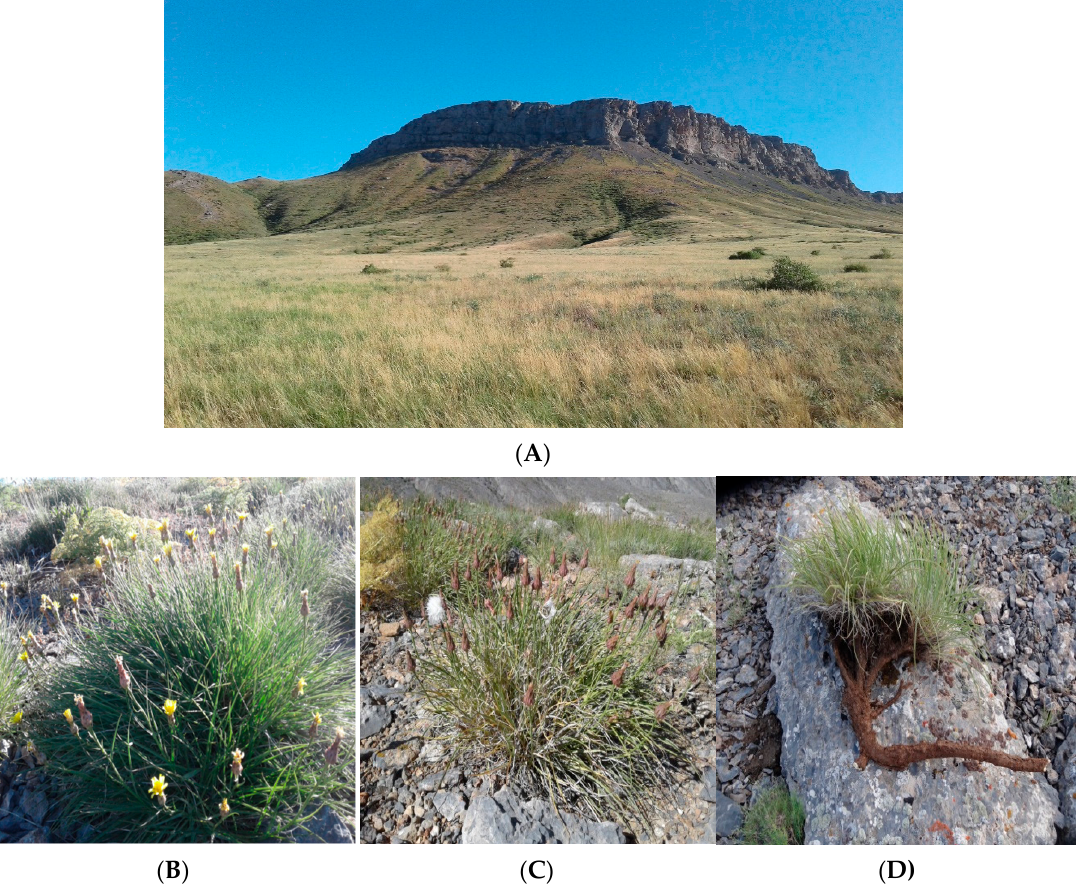
Figure 1. The rare, endangered rubber species Scorzonera tau-saghyz Lipsch. et G.G. Bosse. ( A ) Karatau ridge—a native habitat of the wild species S. tau-saghyz ; ( B ) wild plants in the flowering stage; ( C ) stage of plant development suitable for seed collection (anthodium in the last stage of development); ( D ) root of tau-saghyz.